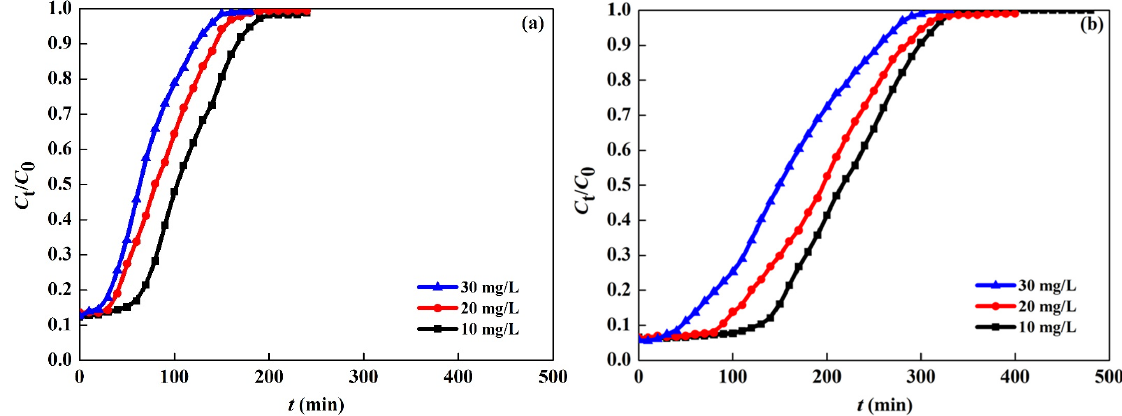
Figure 9. Effect of initial NAP concentrations on column adsorption of NAP onto O-SAC1 ( a ) and O-PCAC1 ( b ) at a flow rate of 2 mL/min and column height of 1 cm.